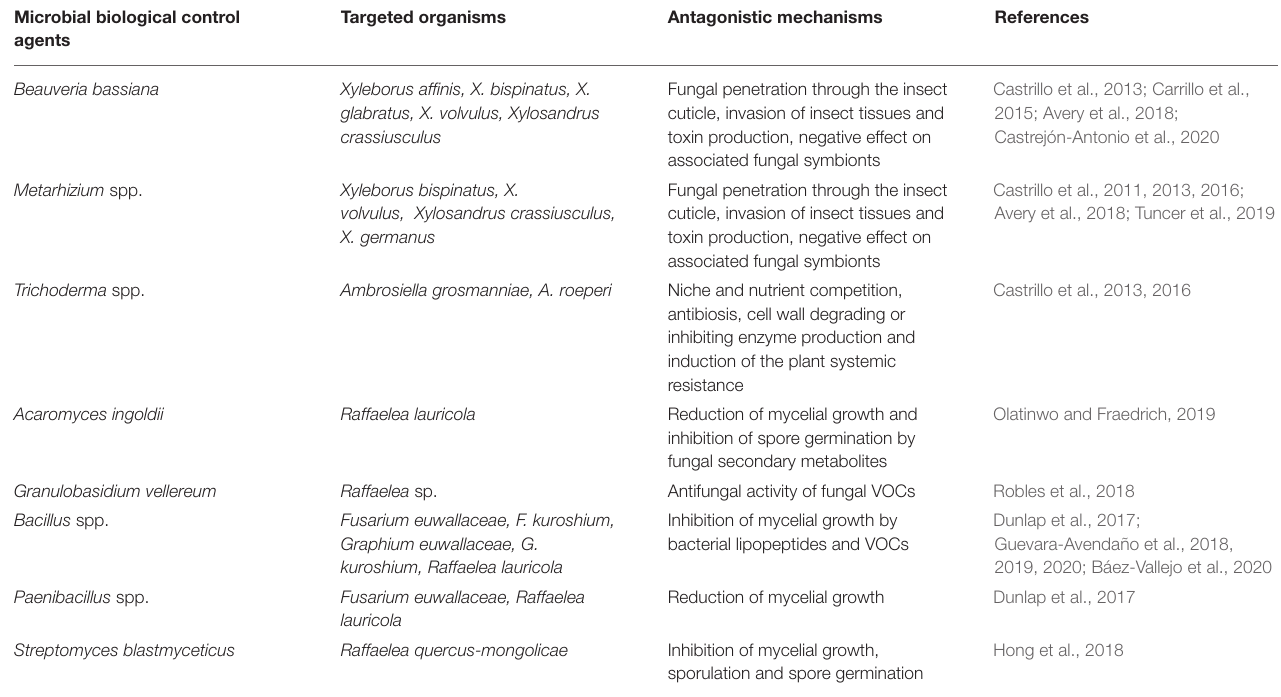
TABLE 1 | Existing microbe-based strategies for the biocontrol of ambrosia beetles and their phytopathogenic fungal